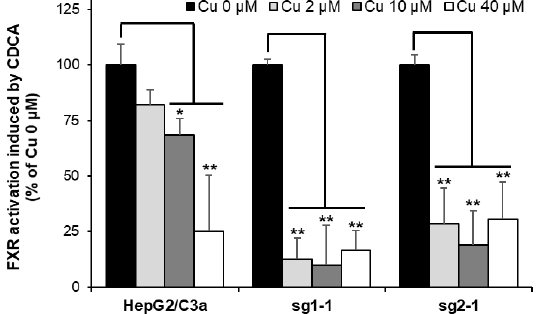
Figure 8. FXR activity impairment in cell lines with or without ATP7B. HepG2/C3a, sg1‑1, and sg2‑1 cells were exposed to increasing concentrations of Cu and to CDCA. BSEP expression was quantified by qRT‑PCR, and the inhibition of FXR was determined by comparing BSEP expression between cells exposed and unexposed to Cu. All the data are expressed as means +/ − standard error of the mean of at least three independent experiments. * stands for data statistically different from the control unexposed to Cu with p < 0.05, and ** stands for data statistically different from the control unexposed to Cu with p < 0.01.